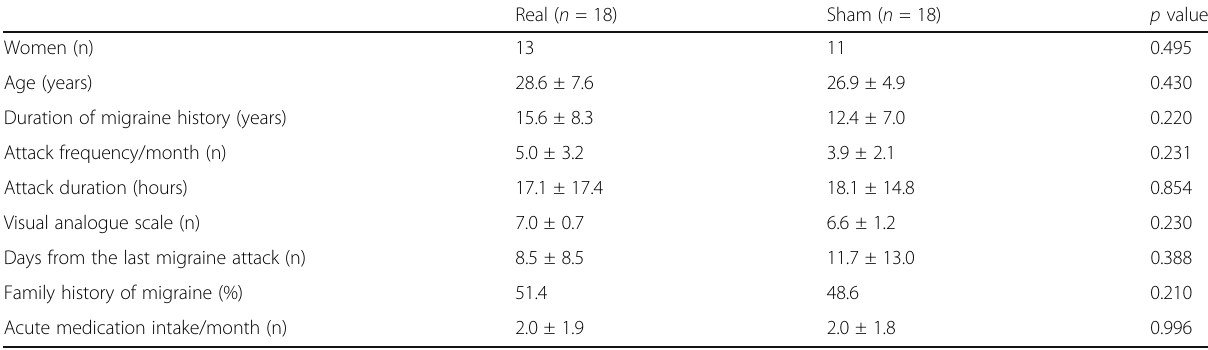
Table 1 Descriptive statistics of clinical and demographic characteristics of migraine patients between attacks in the sham and real